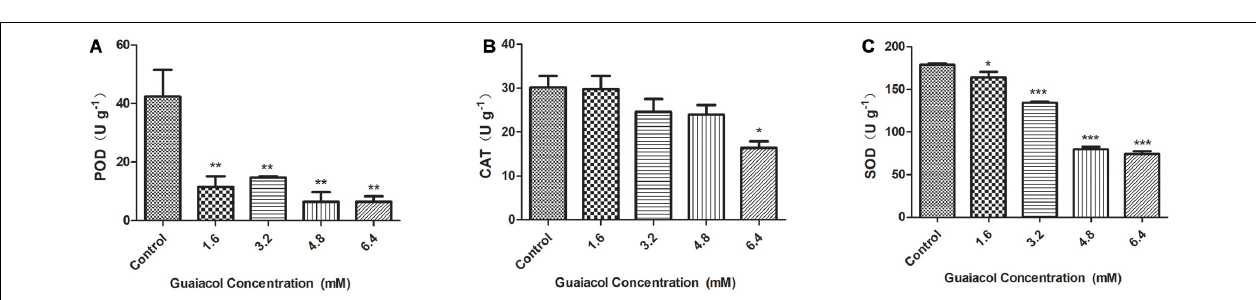
with Tri1-GFP ( (cid:49) Tri1:FgTri1-GFP), indicating DON